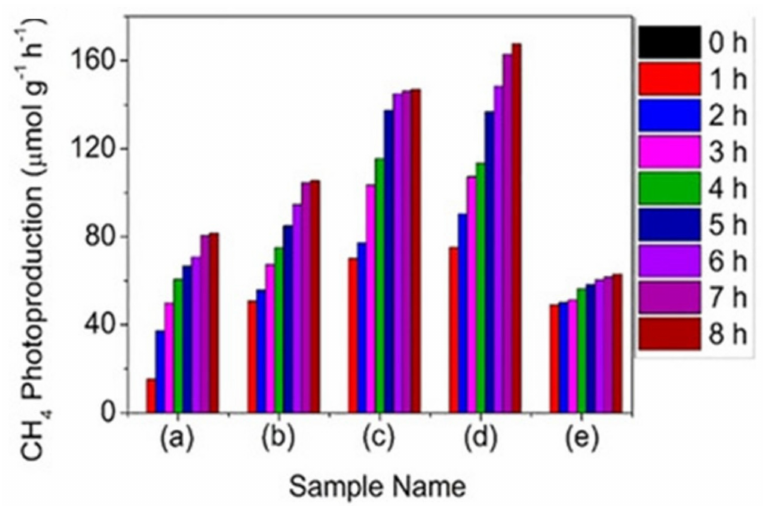
Figure 16. CH 4 photoreduction using Cr 2 O 3 coupled with TiO 2 photocatalysts showing ( a ) Cr 2 O 3 , ( b ) 400-Cr 2 O 3 @TiO 2 , ( c ) 550-Cr 2 O 3 @TiO 2 , ( d ) 700-Cr 2 O 3 @TiO 2 , and ( e ) 850-Cr 2 O 3 @TiO 2